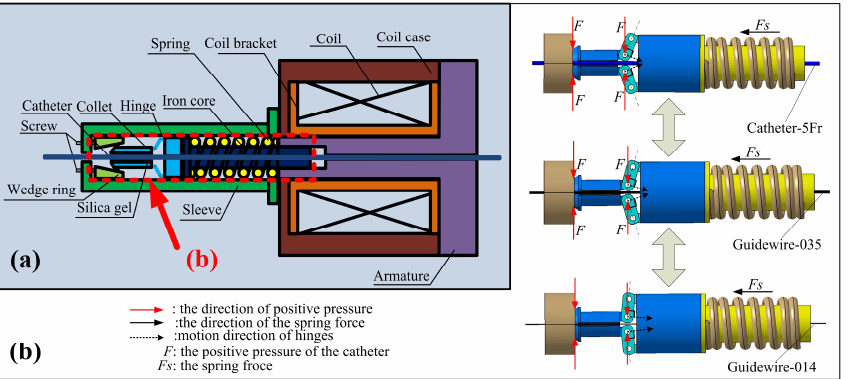
Figure 4. The schematic diagram of the adaptive clamping mechanism. ( a ) An electromagnetic breaking-based adaptive clamping structure. ( b ) The adaptivity of the clamping structure.